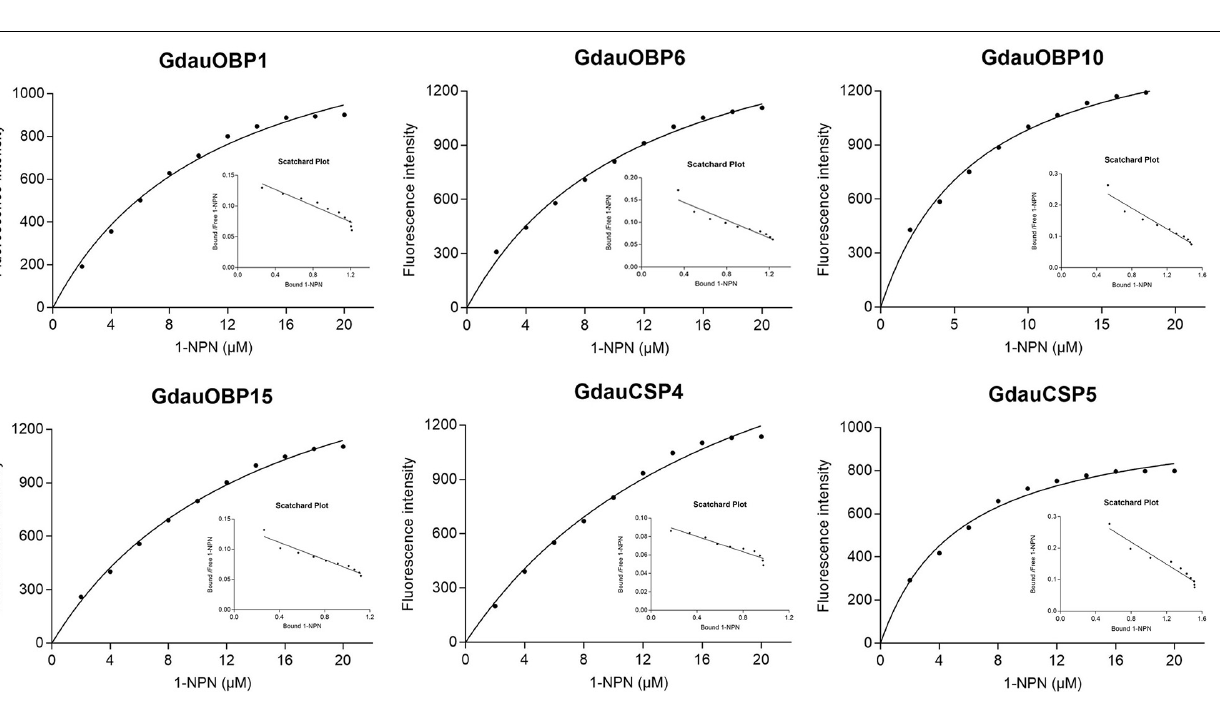
Frontiers in Physiology |